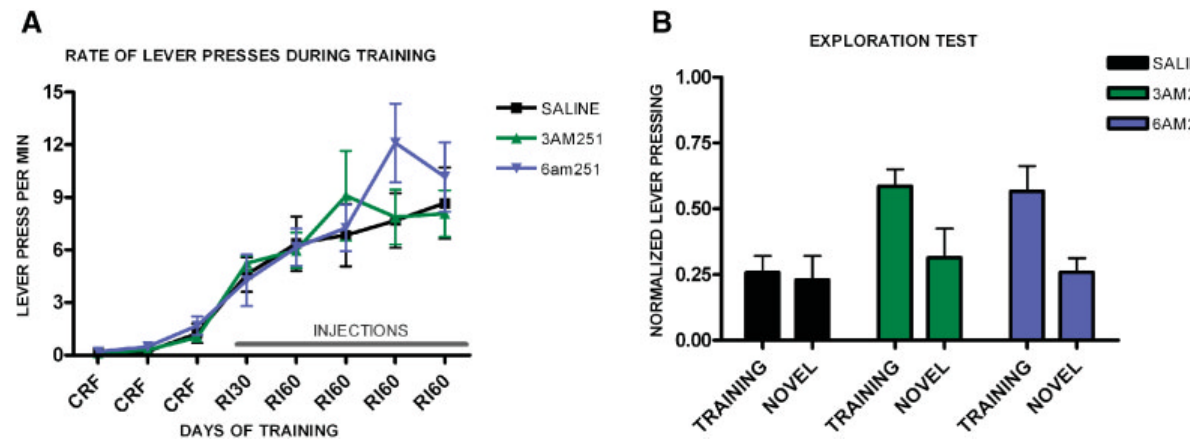
Figure 8. Exploration versus exploitation in C57B16/J mice injected with saline, 3mg/kg AM251 or 6mg/kg AM251. (A) Acquisition of the lever-pressing task for mice injected with saline, 3 mg/kg AM251 or 6 mg/kg AM251 trained on a random interval schedule. The rate of lever pressing (per minute) for each daily session is depicted. Note that animals were only injected during RI-30 and RI-60 training. (B) Lever pressing (normalized) on the training lever versus a novel lever in mice injected with saline, 3 mg/kg AM251 or 6 mg/kg